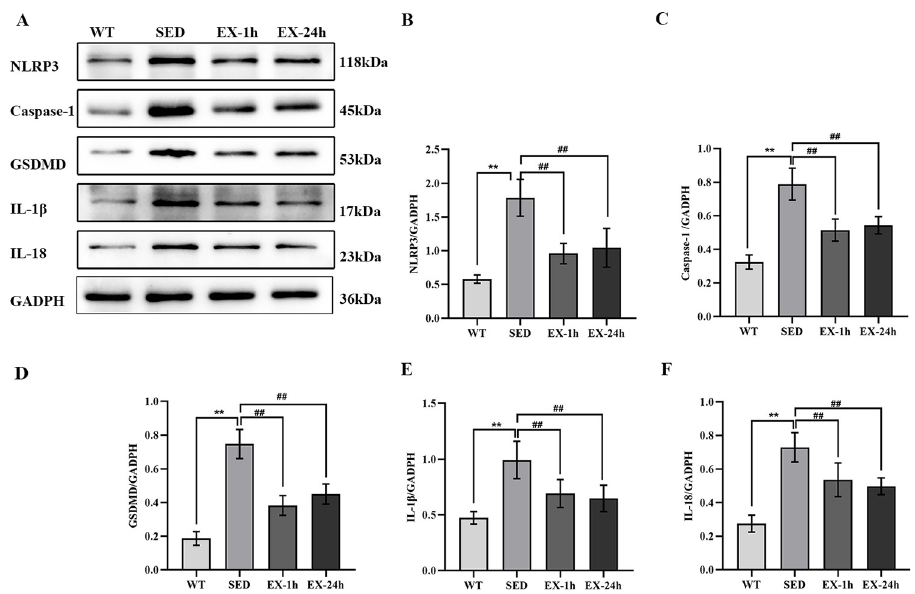
Fig 8. Aerobic exercise inhibits NLRP3 inflammasome-mediated pyroptosis-related factor protein expression in the aorta. ( A ) The protein expression of NLRP3, caspase-1, GSDMD, IL-1 β , and IL-18 in the aorta were detected by western blotting. ( B - F ) Comparison of protein expression in each group (n = 7). Data are presented as mean ± SD of three experiments, �� p < 0.01 vs. WT group; ## p < 0.01 vs. SED group.